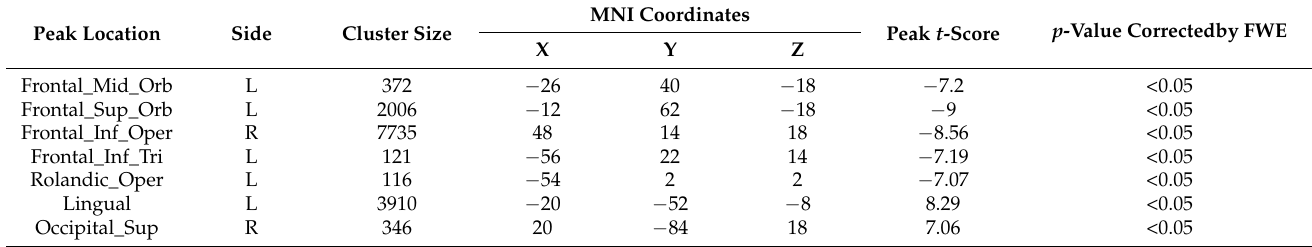
Table 2. The change of CBF after 36 h of acute SD.